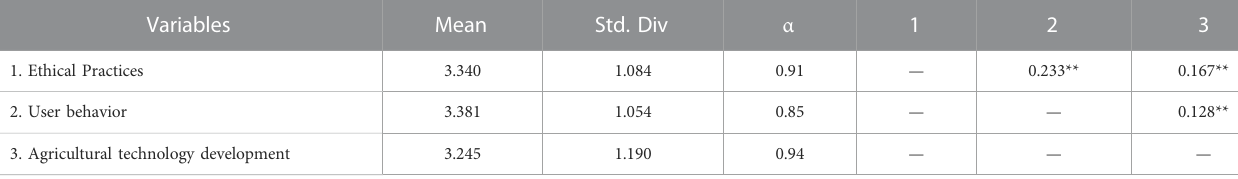
TABLE 2 Means, standard deviations, reliability estimates, and correlations for study variables.